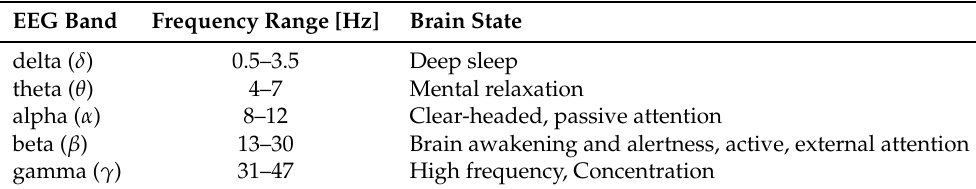
Table 1. Five Bands for Brain